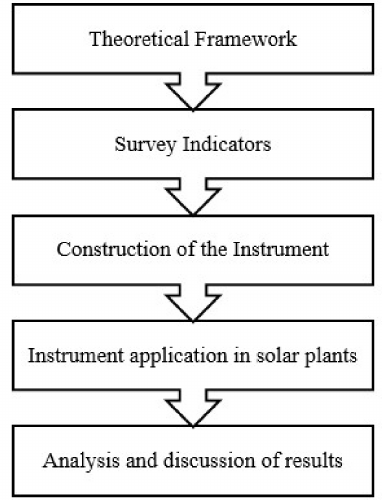
Figure 1. Schematic representation of the